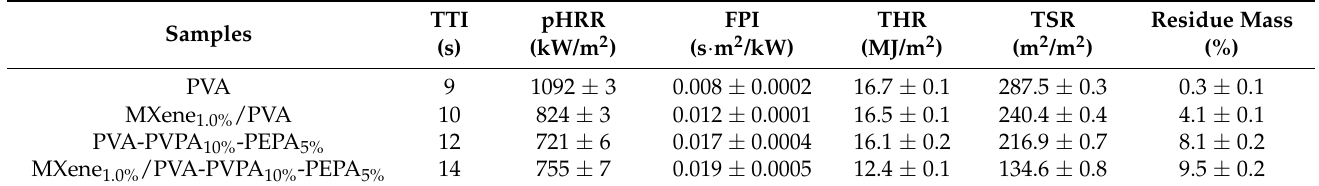
Table 3. Cone calorimetry data of PVA and MXene/PVA nanocomposites.